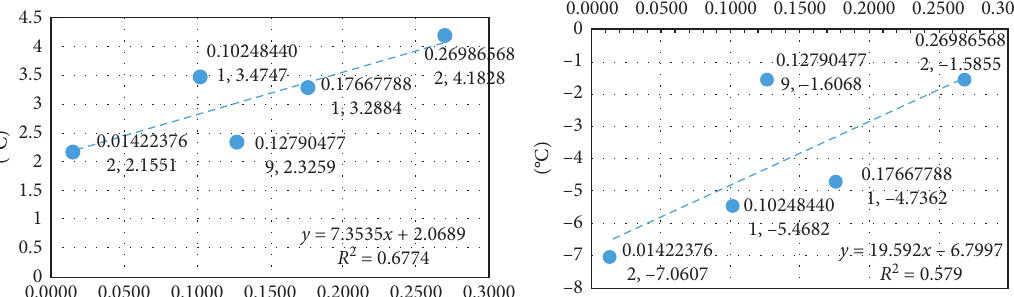
Figure 6: Model of mileage increase percentage with low and high LST linear regression models.